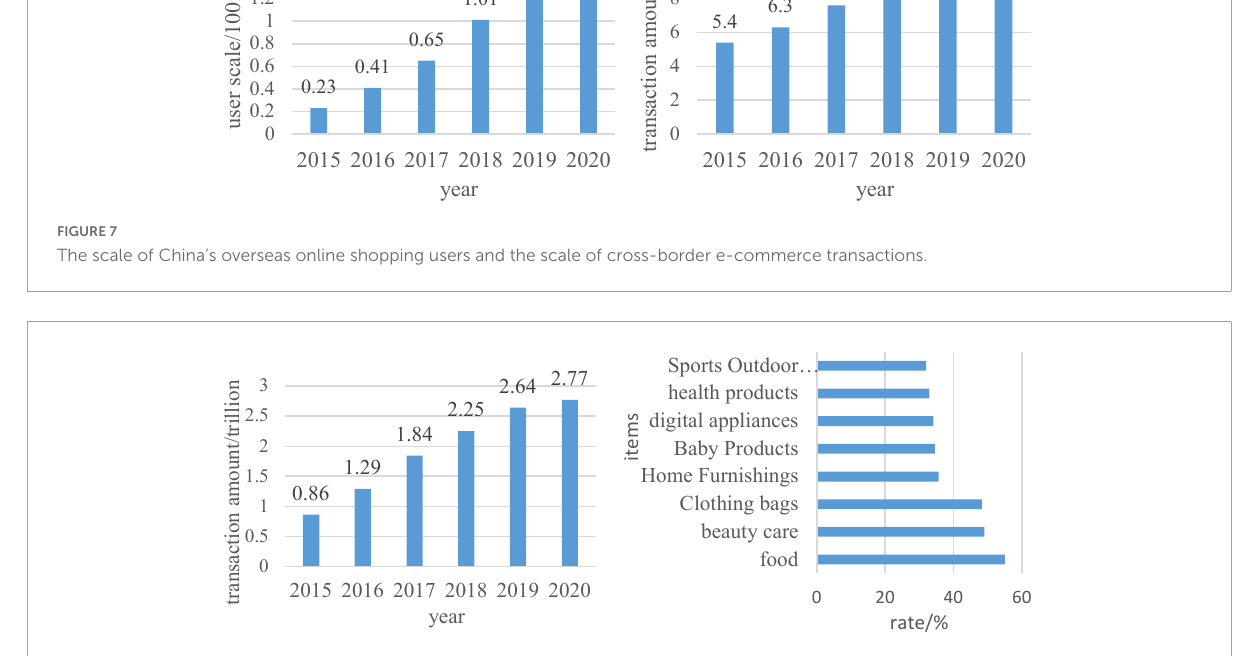
FIGURE8 The scale of China’s imported cross-border e-commerce and the main products purchased by imported cross-border e-commerce in 2018.